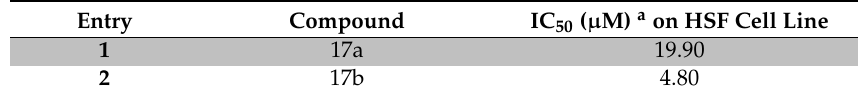
Table 3. Results of the in vitro growth inhibitory of benzimidazoles 17a and 17b against the HSF cell